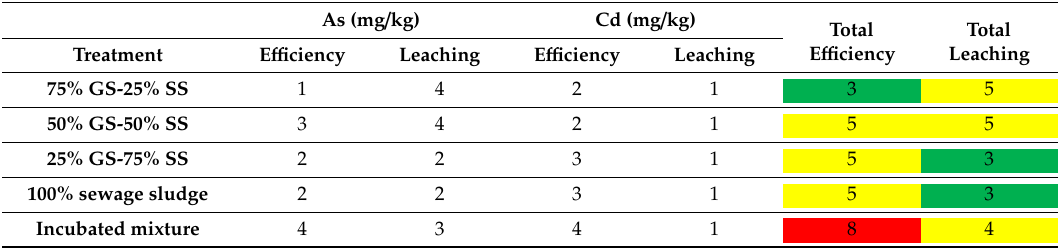
Total e ffi ciency (higher to lower score): red, yellow, green. Total leaching (higher to lower score): red, yellow,